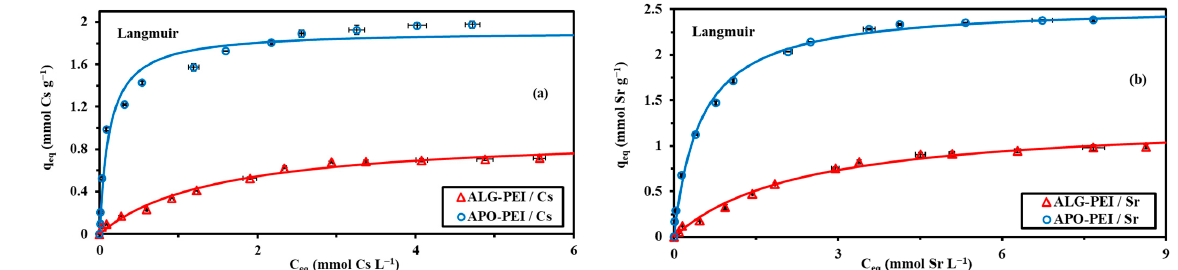
Figure A13. Sorption isotherms for Cs(I) ( a ) and Sr(II) ( b ) using ALG-PEI and APO-PEI sorbents: